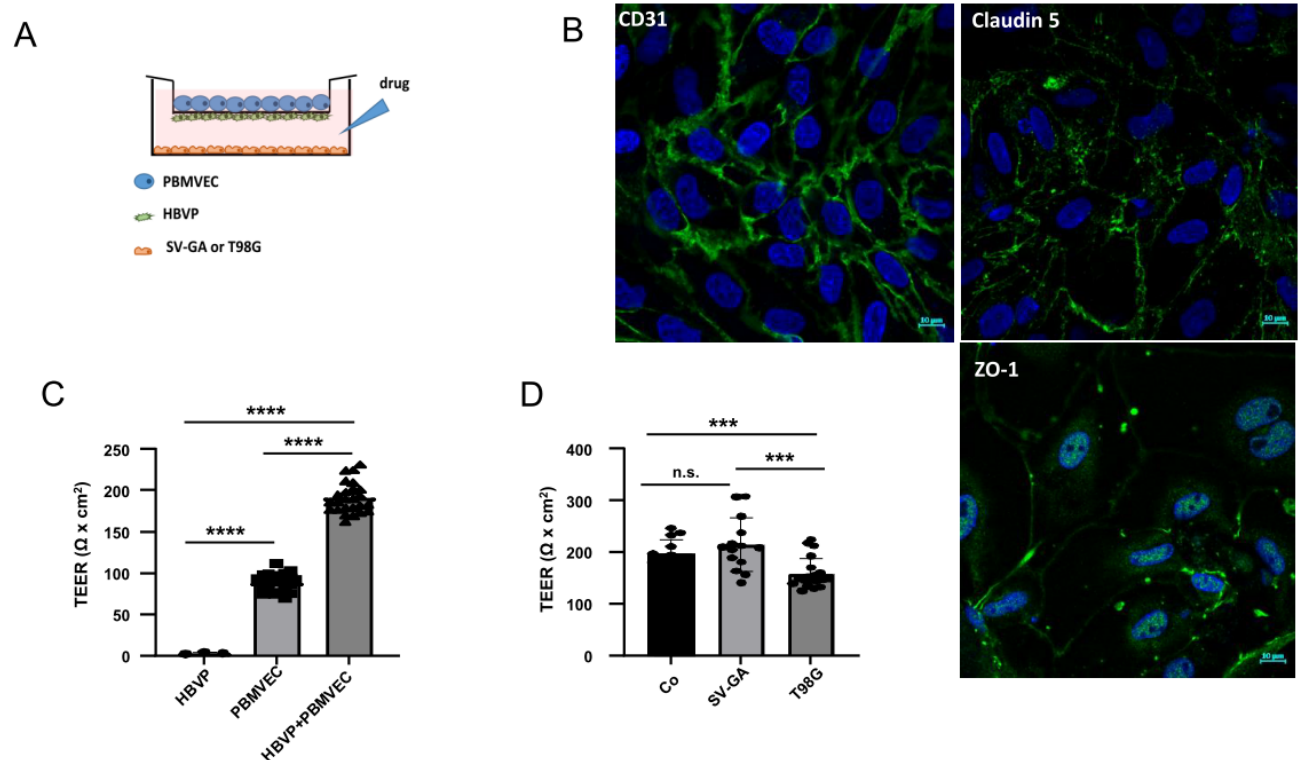
Figure 1. The in vitro blood–brain barrier (BBB) model. ( A ) Scheme of porcine brain microvascular endothelial cells (PBMVEC), human brain microvascular pericytes (HBVP) and SV40 large T-antigene immortalized astrocytic cells (SV-GA) or T98G glioblastoma cell line localization in the BBB co-culture model co-culture. ( B ) CD31, claudin 5 and ZO-1 staining of isolated PBMVEC (bars = 10 µ m). ( C ) The cells were cultivated as described in the material and methods part either as monocultures (HBVP on the bottom insert membrane; PBMVEC on the top insert membrane) or as co-cultures. After 5 days, the membrane integrity was determined by TEER measurement ( n = 3, each up to 10 replicates, SEM, t -test, **** p < 0.0001). ( D ) Co-culture of barrier-tight BBB-layers (containing PBMVEC and HBVP) with SV-GA or T98G cells. TEER was performed 24 h after co-culture (Co: no additional cells were seeded; n > 7, SEM, t -test, *** p < 0.005). Co-culture with astrocytic cells strengthens, with glioma cells weakens barrier integrity. ( C , D ) Circles, squares and triangles at the appropriate bars indicate data points of single